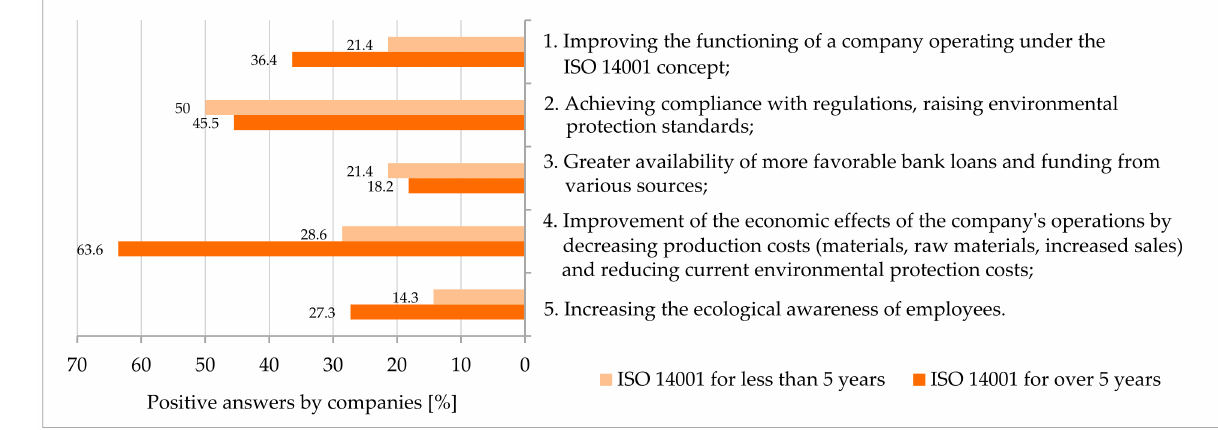
Figure 7. Analysis of internal benefits resulting from the implementation ISO 14001 depending on the duration of the system operation in